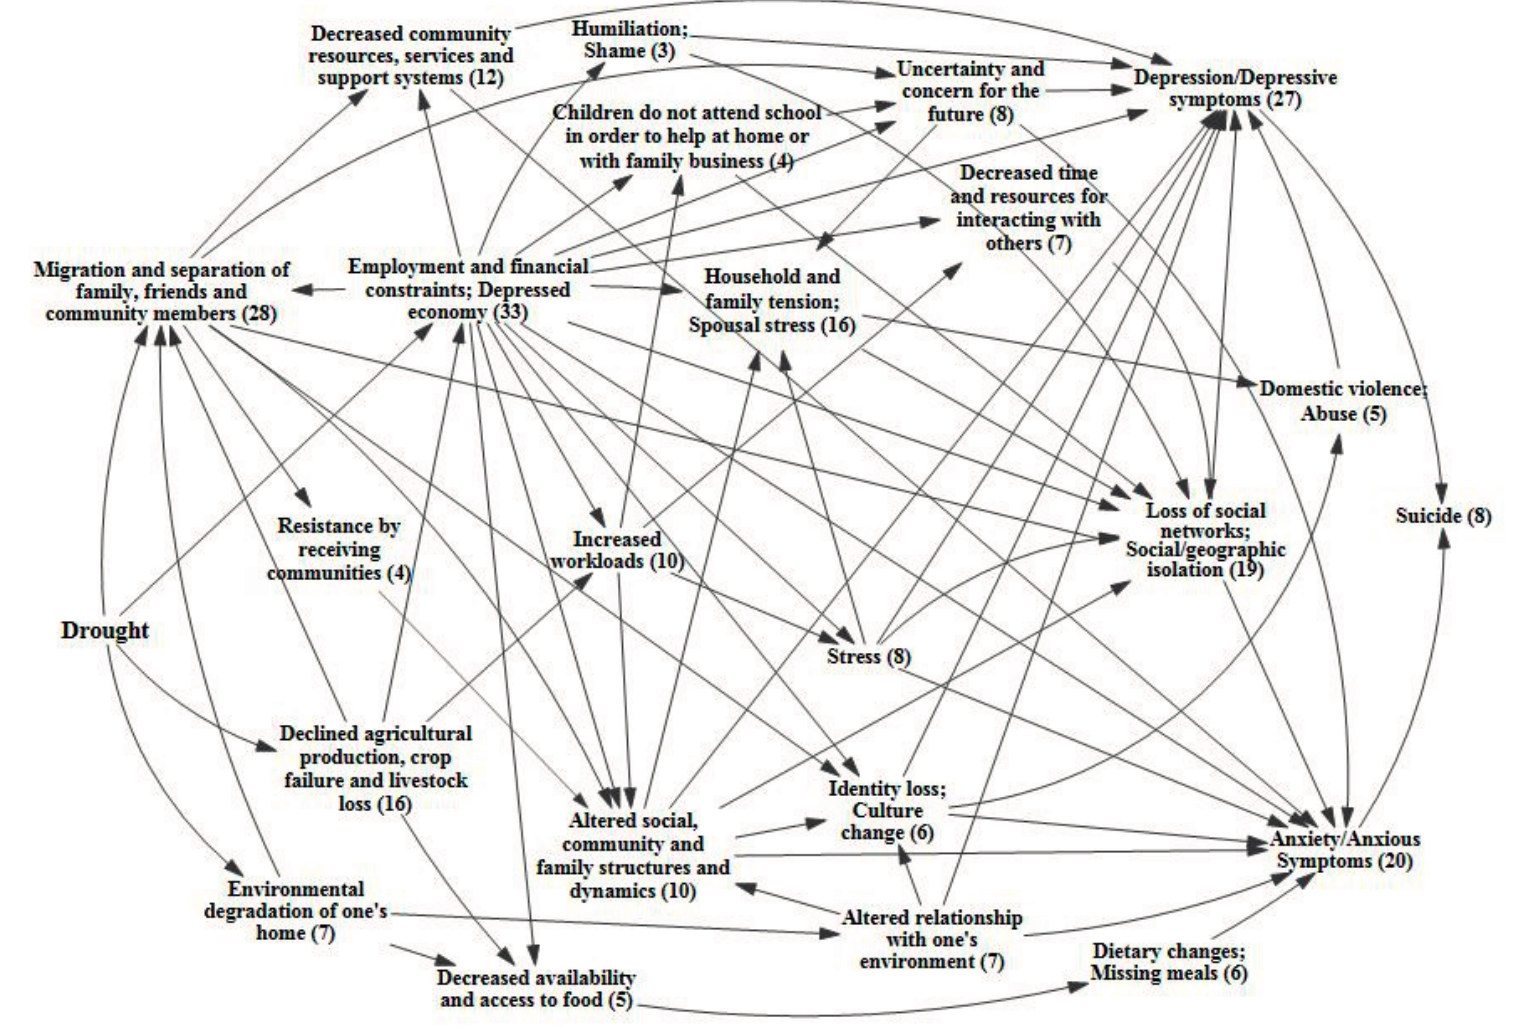
Figure 7. Causal processes diagram for mental health outcomes of